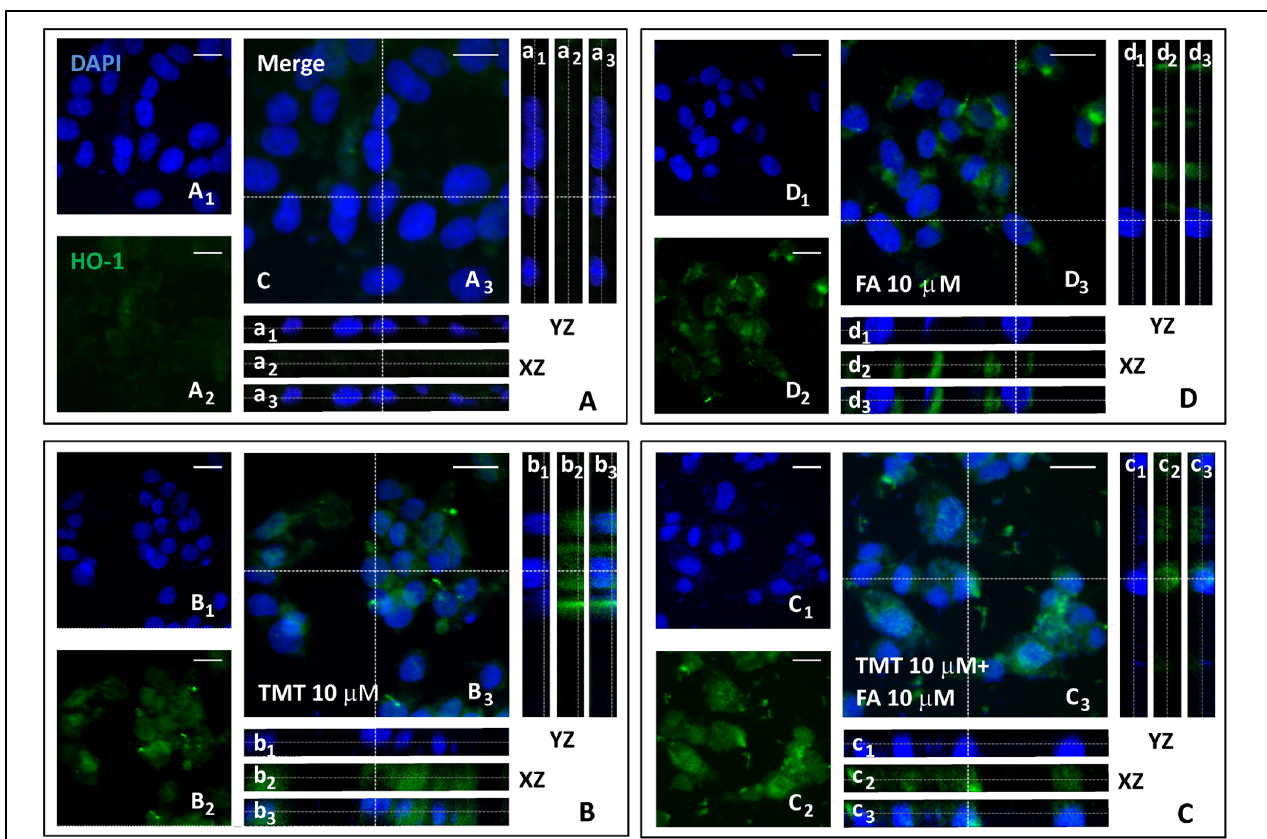
FIGURE 4 | Ferulic acid induces HO-1 expression and its nuclear translocation. (A–D) Representative images from four independent immunofluorescence experiments in which we carried out a double-labeling with DAPI (A 1 –D 1 ) and an anti-HO-1 antibody (A 2 –D 2 ) . Merged images are shown in A 3 –D 3 . XZ and YZ cross-sections in the boxes (referred to the dashed lines) from the confocal Z -stack acquisitions show cytosolic or nuclear fluorescence signal(s) (XZ and YZ boxes: a 1 –d 1 refer to DAPI staining; a 2 –d 2 refer to HO-1 fluorescence; a 3 –d 3 : Merge). In the Control group (A) a faint HO-1 fluorescence localized in the cytosol was detected (a